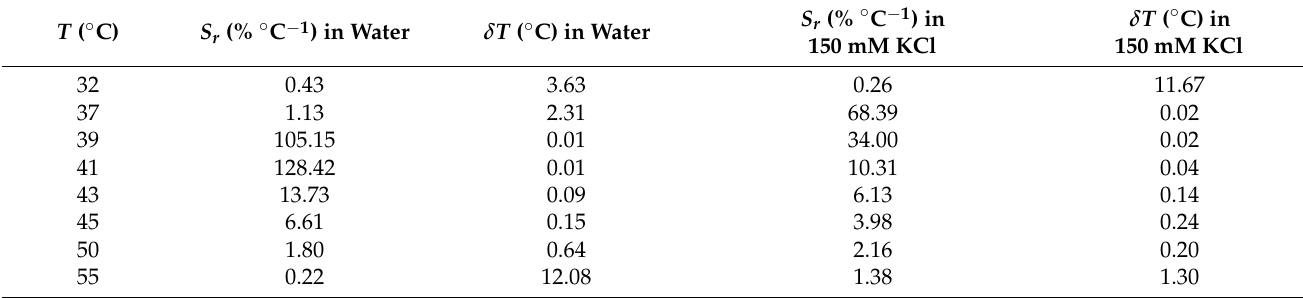
Table 1. Thermometric performance of NG-3 at different